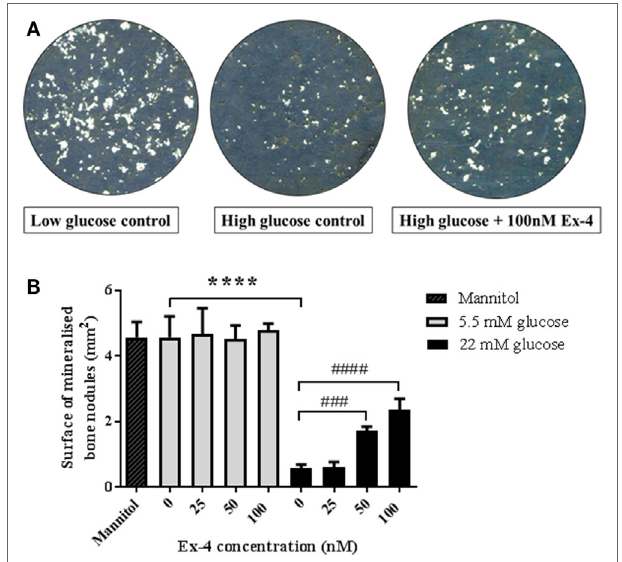
FigUre 4 | Effects of Exenatide on bone nodule formation in vitro under normal and high-glucose conditions. Mouse primary osteoblasts were isolated from calvaria of 2–3 days old pups and cultured for 28 days in six-well plates in osteogenic medium (with addition of ascorbate and β -glycerophosphate) in either normal (5.5 mM) or high- (22 mM) glucose concentration. Exenatide was added to the cells in normal and high-glucose conditions at various concentrations (0, 25, 50, and 100 nM). A control with 22 mM of mannitol was used as an osmotic control to ensure that changes in bone formation is due to glucotoxicity rather than hyperosmolarity. Mineralized nodules representing bone formation were scanned and observed unstained. Quantification of mineralization was performed using Image J. (a) Imaging of bone nodules using contrasting color on photoshop to visualize the bone nodules that appear in white. (B) Quantification of the area of bone formation by osteoblasts cultured with glucose and Exenatide. Mean ± SD of six wells/group. **** P < 0.0001 versus low glucose condition; #### P < 0.0001, ### P < 0.001 versus no Exenatide. Experiments were performed three times in triplicates and graphs are representative of one